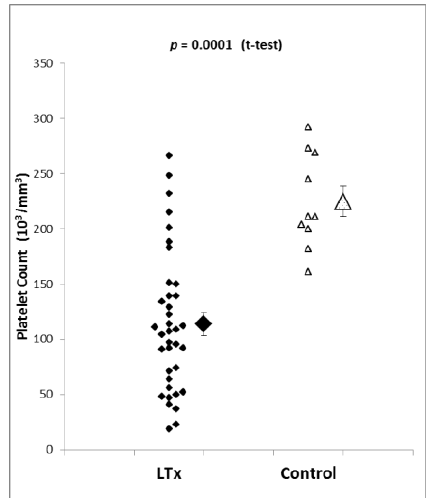
Figure 1. Platelet concentration in the liver transplantation group (LTx, n = 37) and control group ( n = 10). Platelet count is significantly higher in control patients. Shown are both individual measurements and mean and standard error of the